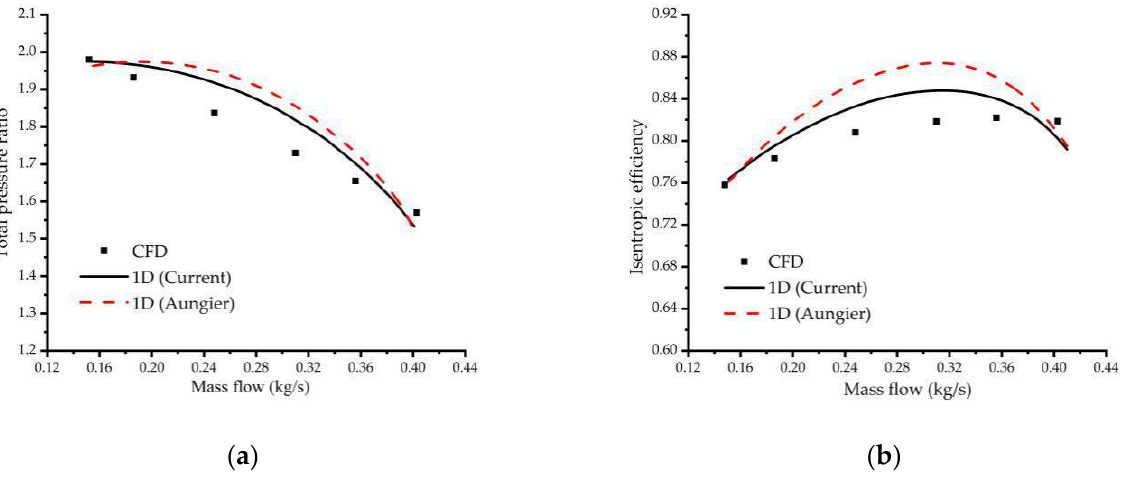
Figure 7. Performance comparison for two methods for Impeller R: ( a ) Total pressure ratio; ( b ) Isentropic efficiency.